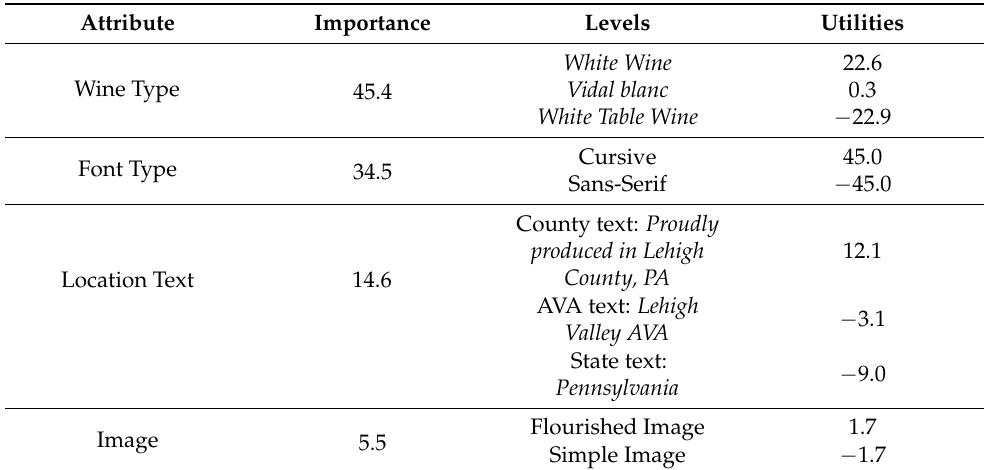
Table 4. Utilities and importance values as estimated by the Hierarchical Bayes (HB) model for the entire survey population ( n =